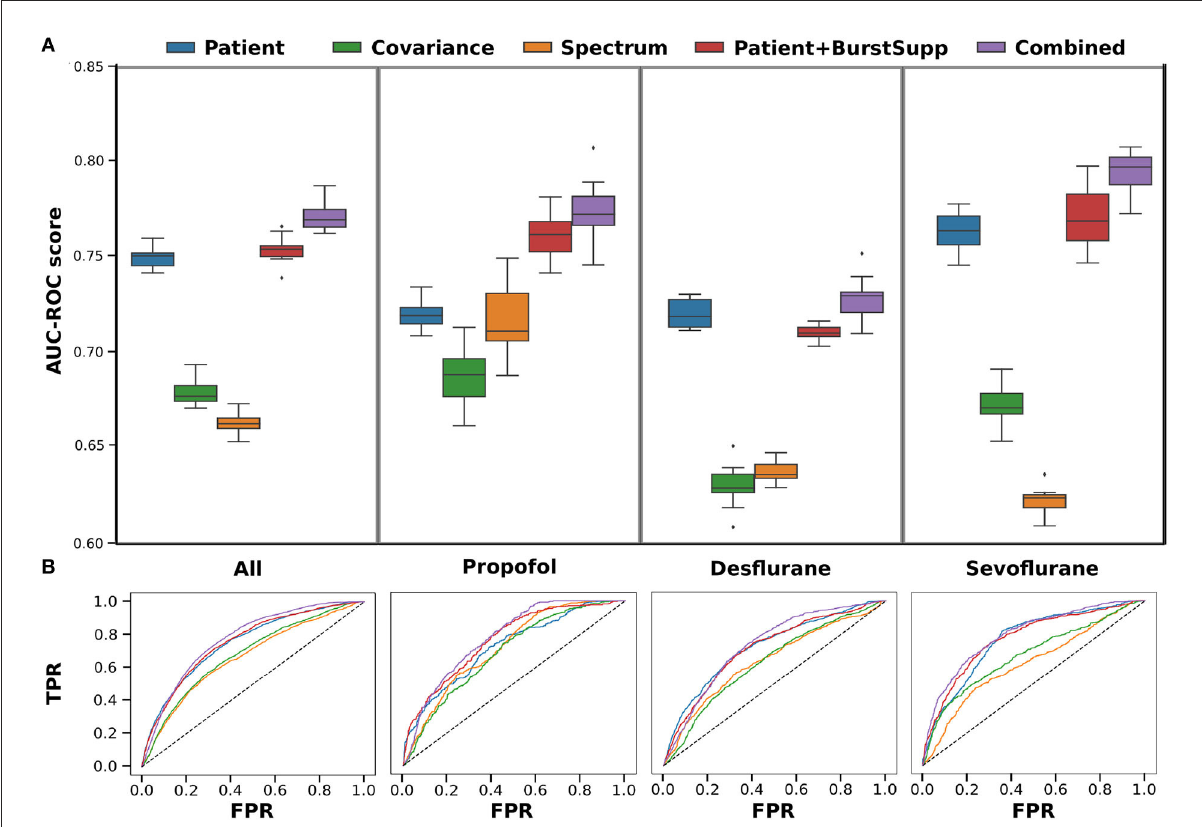
FIGURE6 Cross-validation-results for training on group-specific data. Results shown for each medication group, left all, 2. Propofol, 3. Desflurane and right Sevoflurane, for each of the classifiers patient (features: anesthetic agent, benzodiazepine, ASA, Age, OP length) (blue), covariance (green), spectrum (orange), patient+burstsupp (patient and burst suppression features) (red), combined risk evaluation (violet). The medication group all includes all medications, the classifiers for each patient are based on the given medication group shown on the right. If patients do not fall into one of the groups, receiving other mixed medications, they are classified by the classifier trained on all medications. (A) ROC-AUC values in a box plot over 10 repeats of a 10-fold cross-validation. (B) Mean ROC-curves for 10 repeats of a 10-fold